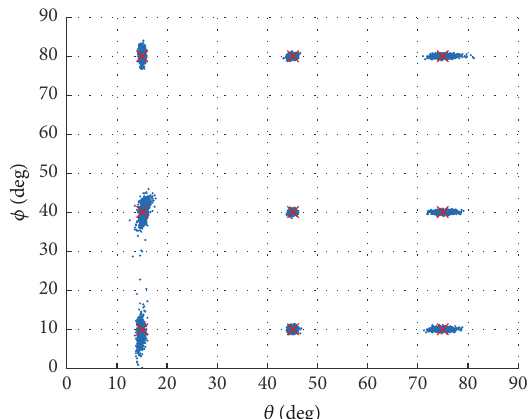
Figure 6: 2D DOA estimation results of 9 incident signals, SNR = − 5